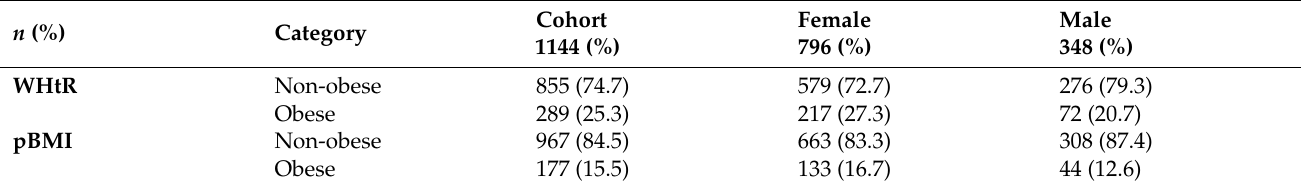
Table 2. Prevalence of obesity based on WHtR and BMI